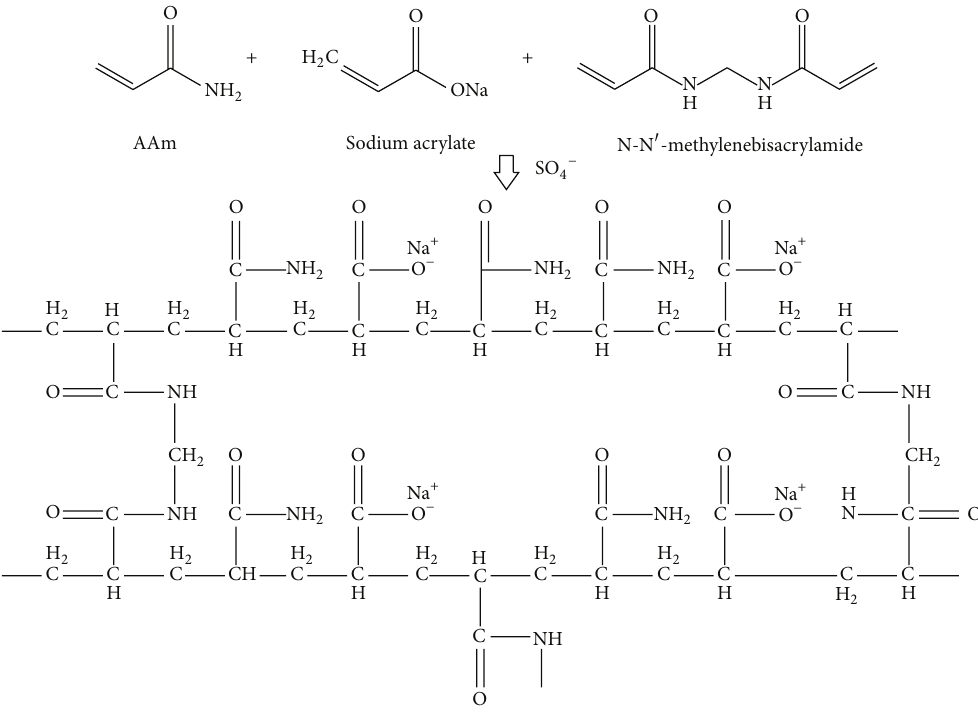
Figure 1: Preparation of cross-linked (AAm/SA)